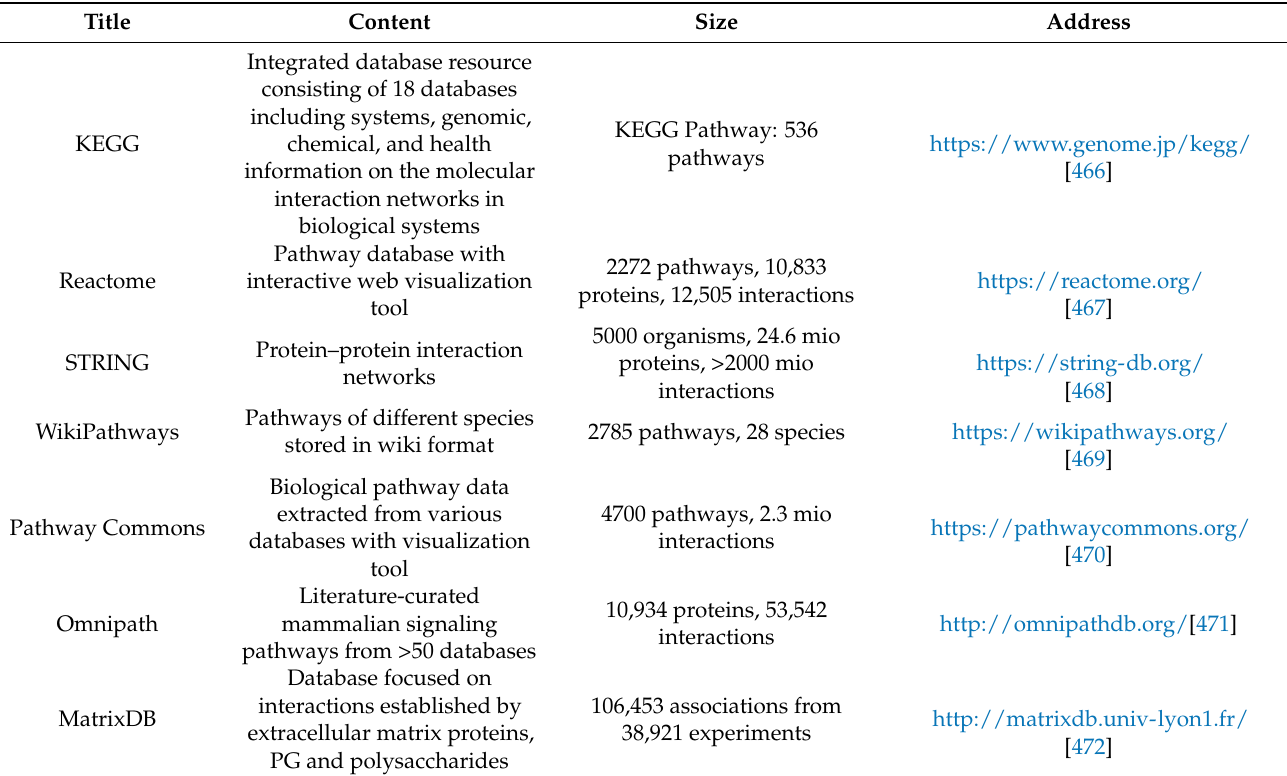
Table 2. Publicly available databases on signaling pathways and protein–protein